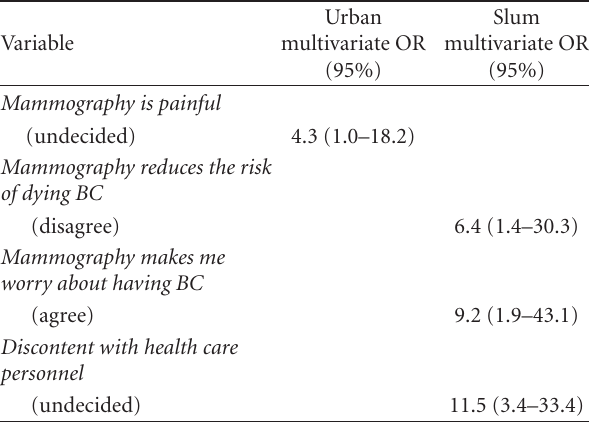
Table 6: Multivariate OR’s of nonattendance at mammography according to